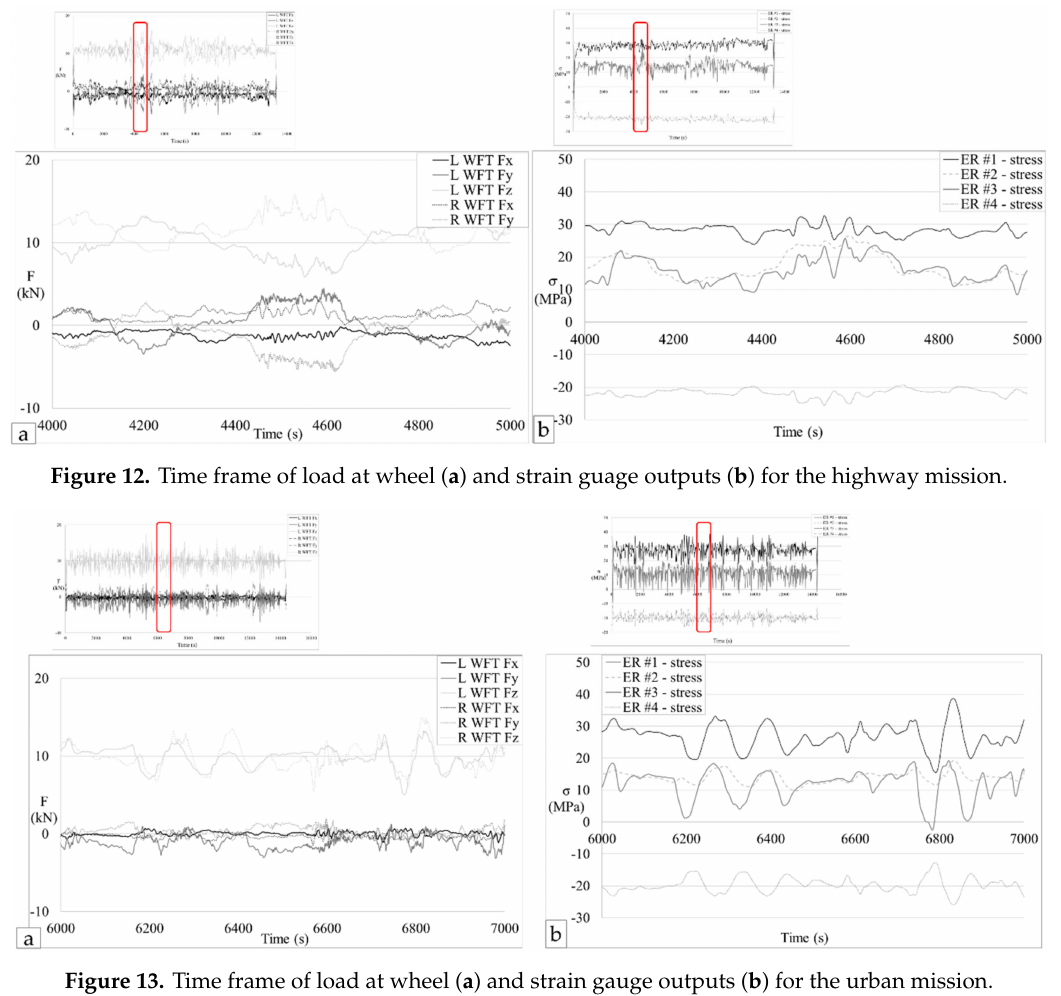
Figure 13. Time frame of load at wheel ( a ) and strain gauge outputs ( b ) for the urban